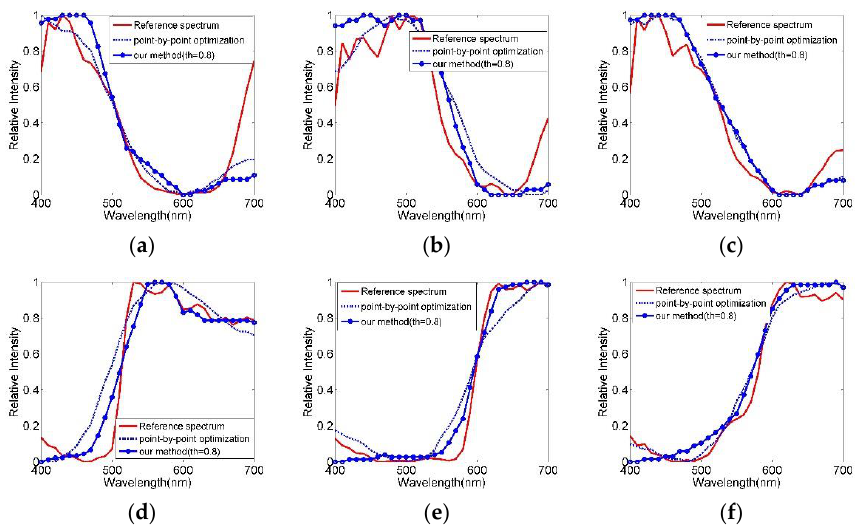
Figure 5. Spectra comparison for different spatial regions and colors (reference spectra, point-by-point optimization directly, our method with th = 0.8). The ( a – f ) curves correspond to the spatial regions ‘A–F’ in Figure 3a.